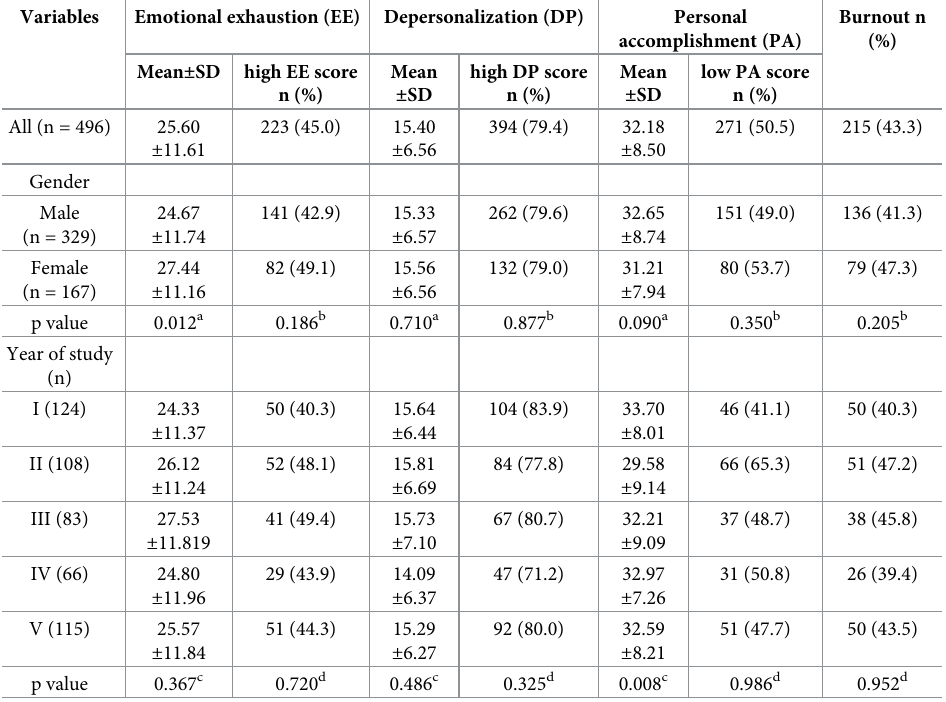
Table 1. MBI subscale scores and burnout prevalence by student gender and year of